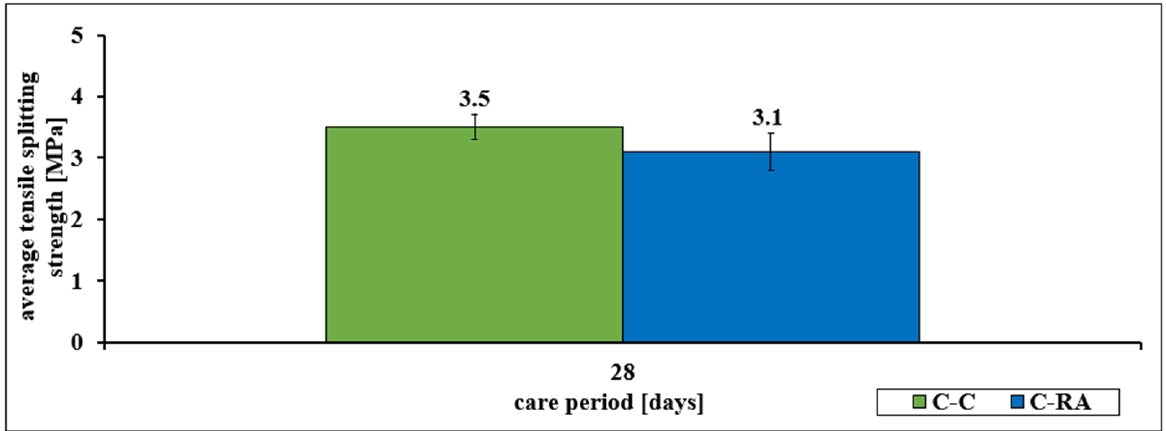
Figure 2. Change in the average tensile splitting strength of concretes of the C-C and C-RA series.